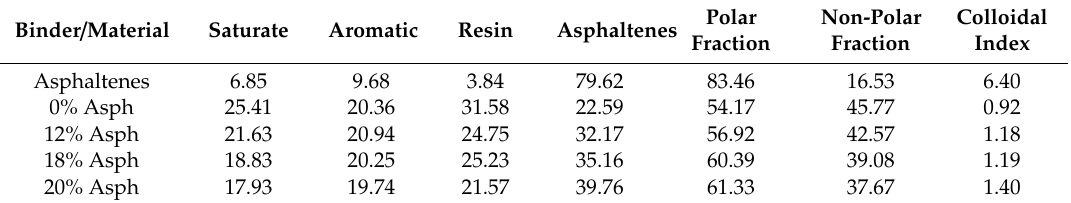
Table 4. SARA analysis results for select asphalt